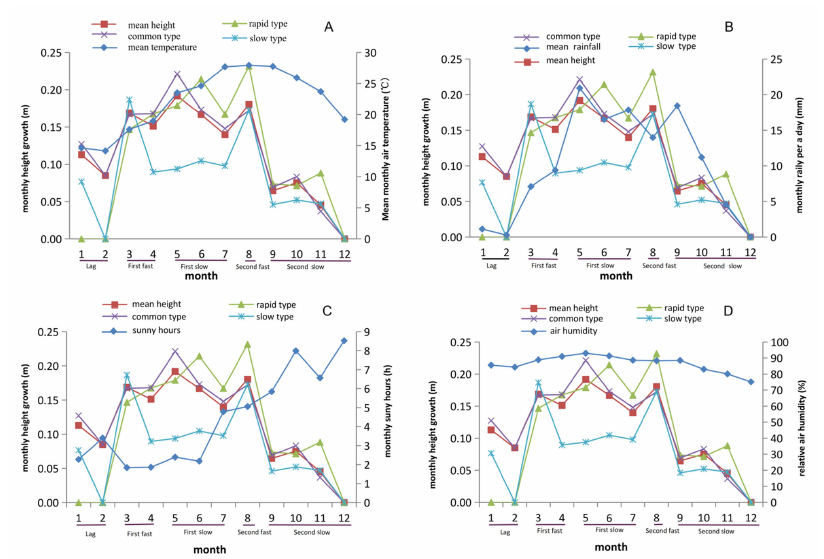
Figure 3. Dynamics of monthly height growth and meteorological factors including temperature ( A ); rainfall ( B ); sunshine hours ( C ); and relative humidity ( D ). Meteorological data were supplied by Gaoming Meteorological Bureau, Foshan City, Guangdong Province, China.